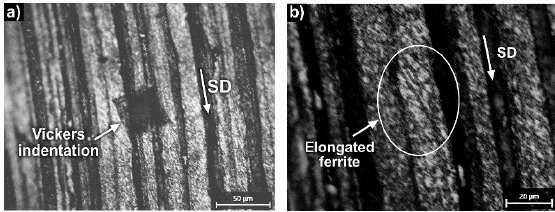
Figure 9. Worn surface lubricated with Castor oil at 70 °C: Vickers indentation ( a ) and microstructure of steel ( b ).